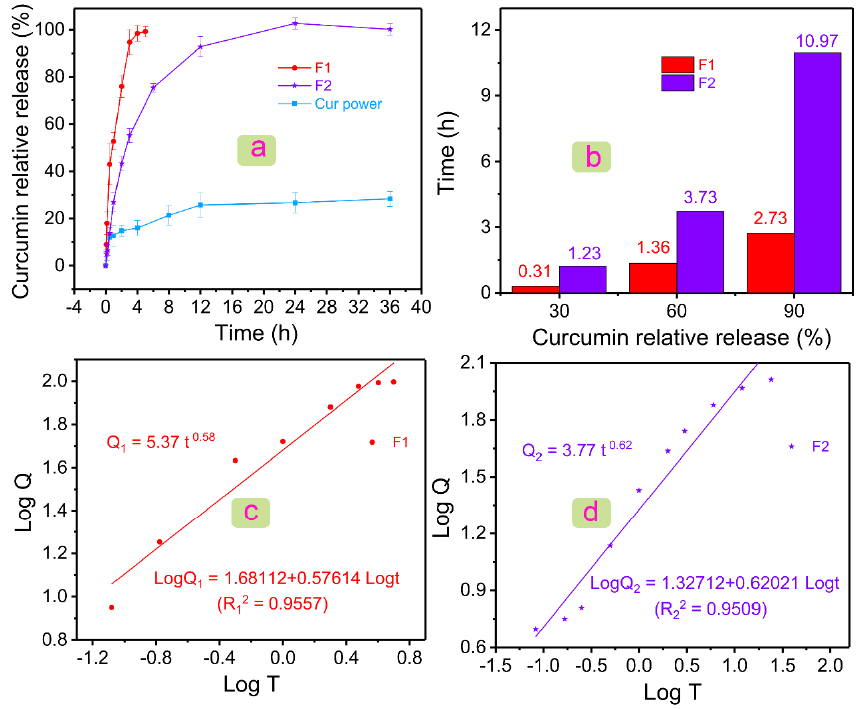
Figure 5. Drug dissolution results and analysis. ( a ) Relative release profiles of Cur powder, F1 fibers, and F2 fibers in 36 h. ( b ) Histogram of the relationship between Cur relative release and time in F1 and F2 fibers. Linear relationship between Log T and Log Q of ( c ) F1 and ( d ) F2 fibers, where Q is the relative release amount of Cur.